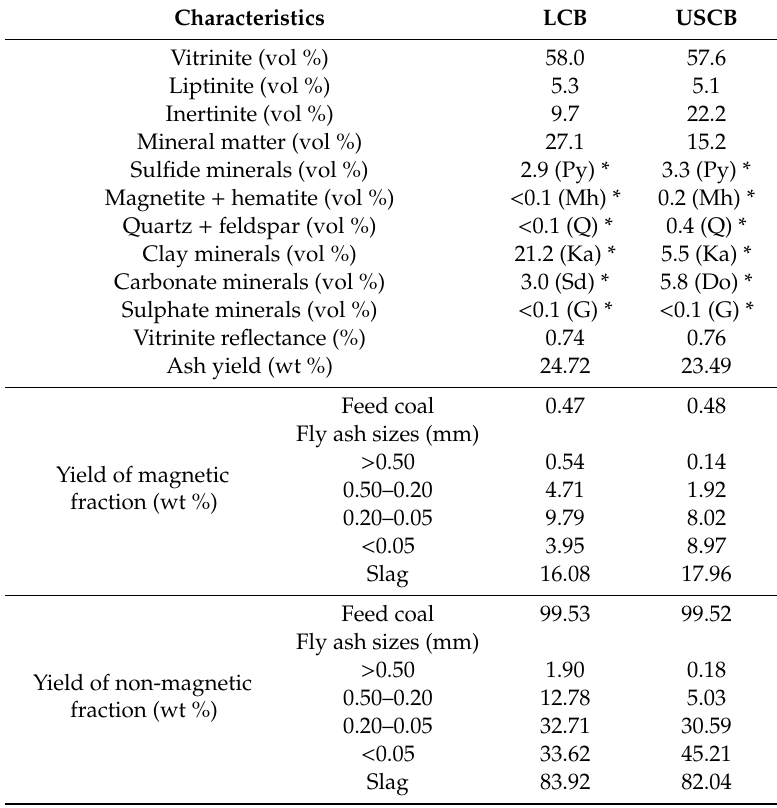
Table 1. Petrographical characteristics of feed coal from the Lublin (LCB) and Upper Silesian Coal Basin (USCB), and yield fraction of the feed coal, fly ash, and slag.